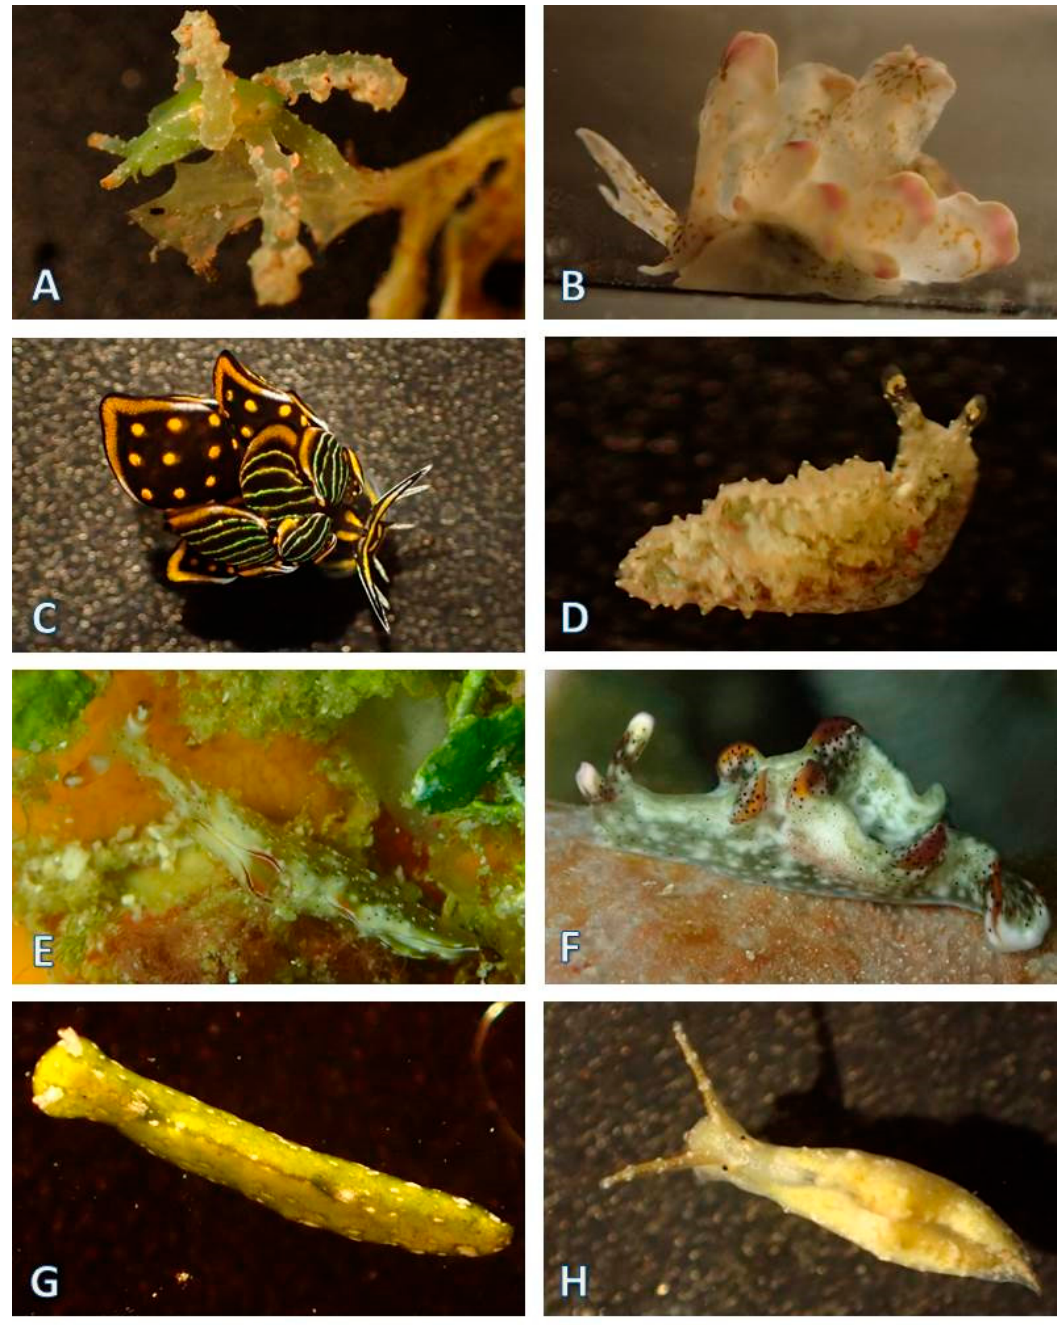
Figure 3. Sacoglossa: ( A ) Lobiger sp. ( Lobiger sp. 1 in Gosliner et al. [24]: 70), Losp1-18Ba1; ( B ) Cyerce bourbonica , Cybo18Ba-1; ( C ) Cyerce nigra , Cyni18Ba-1; ( D ) Elysia asbecki , Elas18Ba-1; ( E ) Elysia marginata , Elma17Ba-1; ( F ) Elysia cf. nigropunctata , Elni18Ba-1; ( G ) Elysia pusilla , Elpu18Ba-2; ( H ) Elysia sp. ( Elysia sp. 24 in Gosliner et al. [24]: 89), Elsp24-18Ba-1.